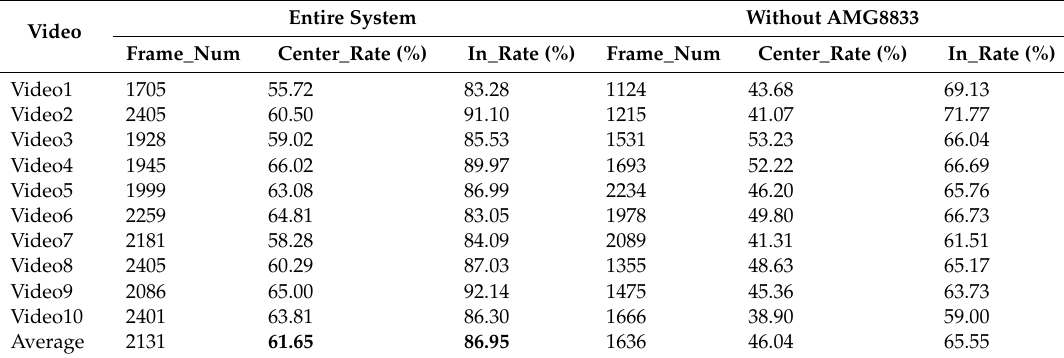
Table 4. Comparative result of the ratios in the two